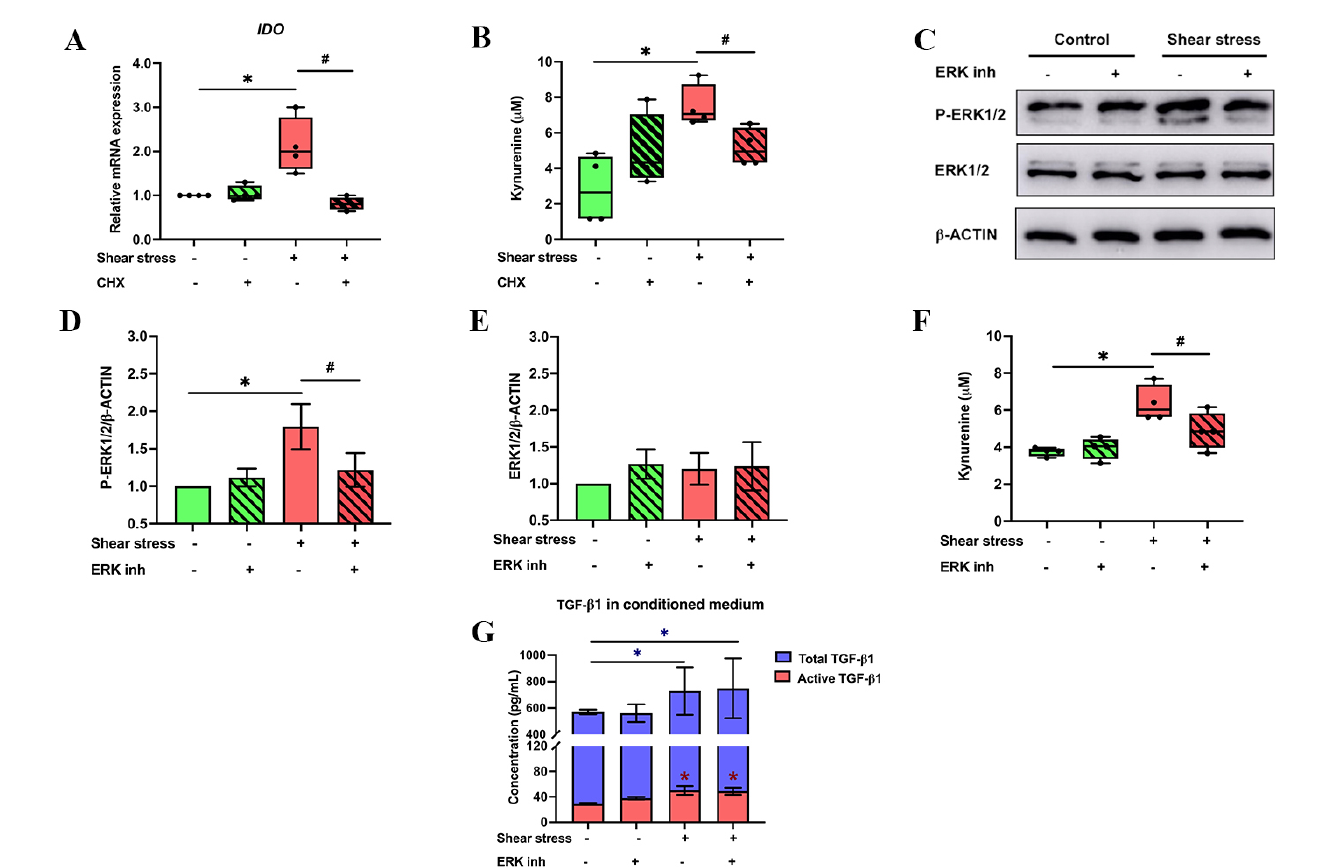
Figure 3. Shear stress enhanced IDO expression and IDO-catabolised kynurenine product in hPDLSCs via ERK1/2 signalling pathway. After shear stress stimulation (at 5 dyn/cm 2 ), hPDLSCs treated with CHX were examined for IDO mRNA expression and kynurenine product ( A , B ). The activity of ERK1/2 was examined by Western blot analysis ( C ). The quantitative analysis of Western blot band intensity showed that ERK inhibitor attenuated P-ERK1/2 ( D ), but not ERK1/2 expression in shear stress-induced hPDLSCs ( E ). The addition of an ERK inhibitor inhibits the effect of shear stress-induced kynurenine secretion ( F ). However, shear stress did not affect TGF- β 1 secretion ( G ). * p < 0.05 vs. non-shear stress without ERK inhibitor group. # p < 0.05 vs.